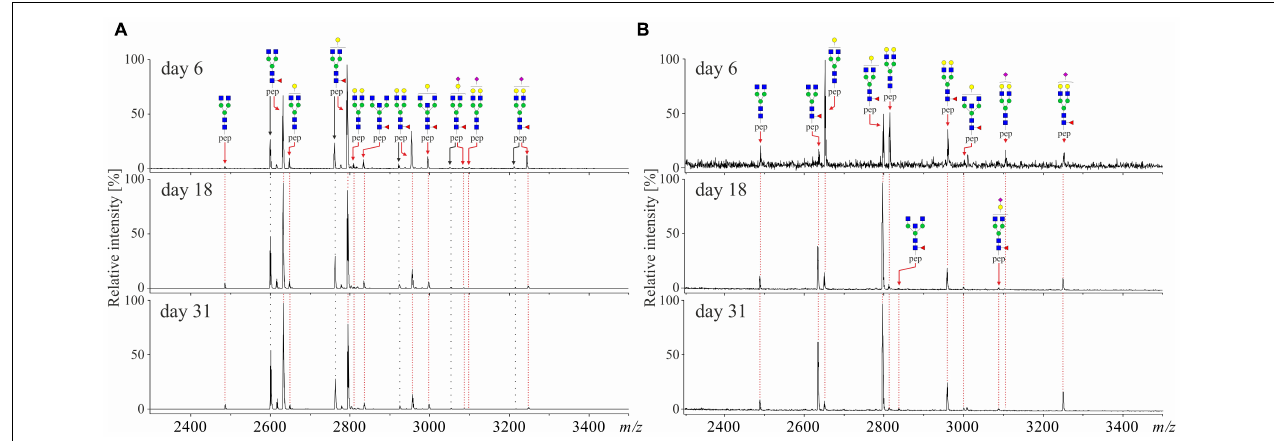
FIGURE 2 | Representative MALDI-TOF-mass spectra [M-H] - of (A) total IgG 1 / 2 and (B) anti-Spike IgG 1 isolated from plasma of severe COVID-19 patient (male, age 51) at beginning (day 6), midpoint (day 18), and the end (day 31) of the disease. IgG 1 glycopeptides are marked in red and IgG 2 glycopeptides are marked in black.